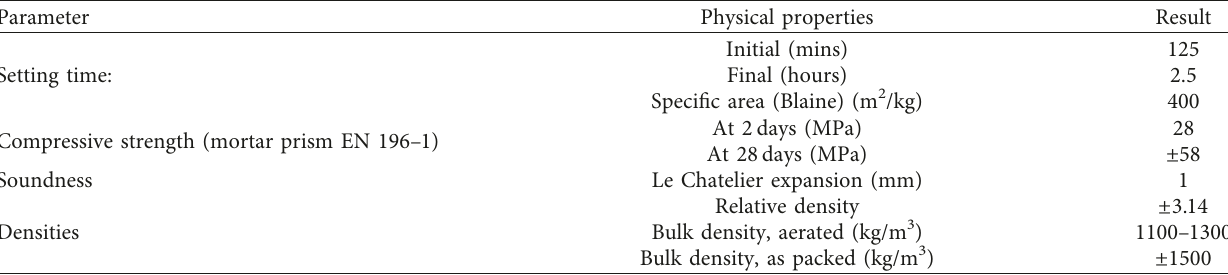
Table 1: Product specifications for Suretech Cement from PPC [28].